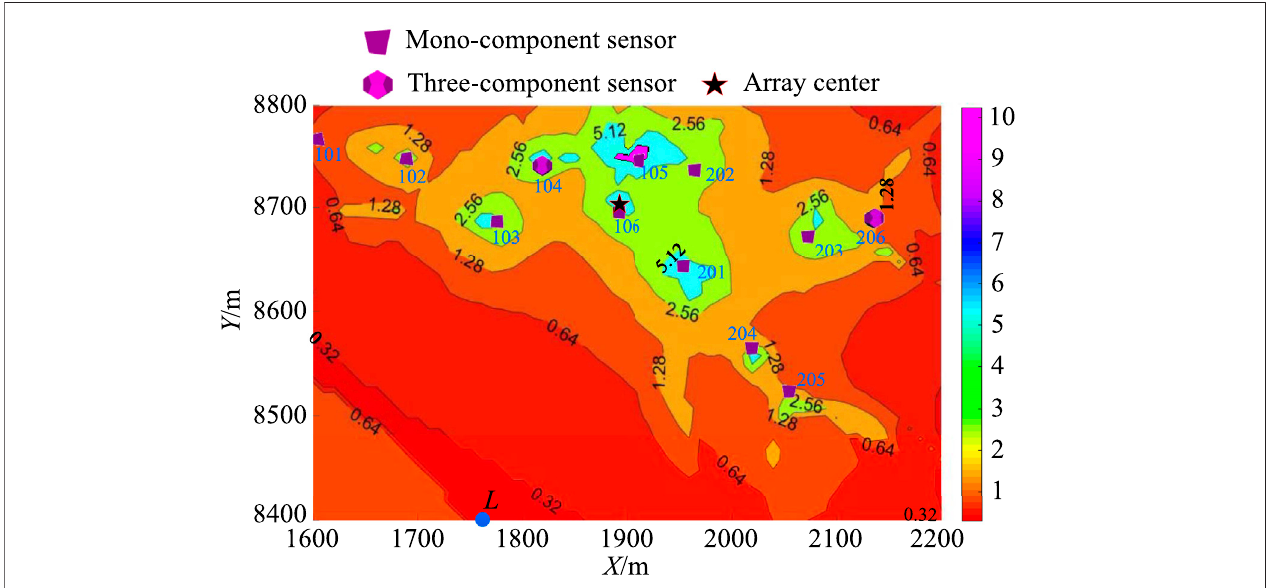
FIGURE 5 | Contour diagram of the sensor coordinate error threshold at the -200 m level.